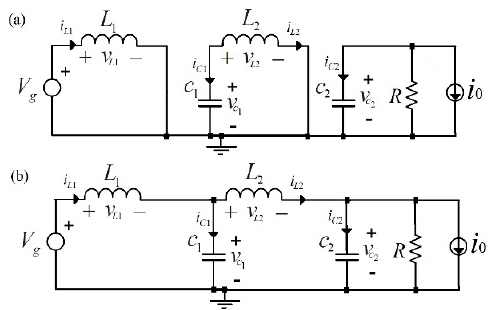
Figure 7. Cascade-boost converter topologies: ( a ) ON, and ( b ) OFF.